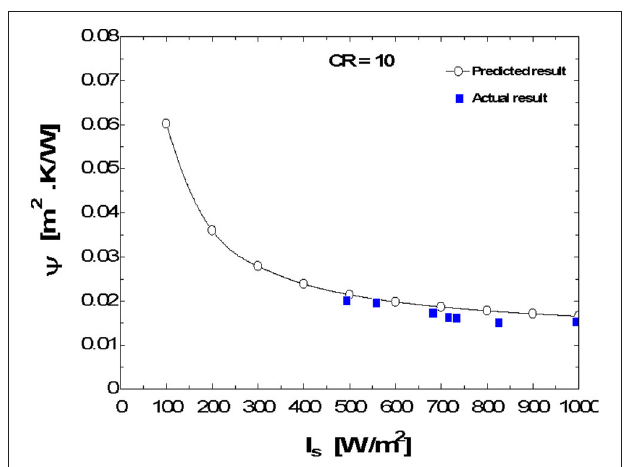
FIGURE 12 | Comparison of the predicted and the actual results of the plots of hot junction temperature T h vs. insolation I s at CR = 10.